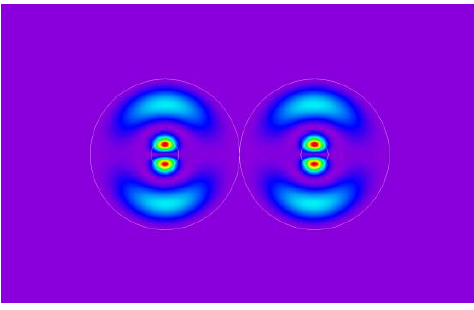
Figure 6. 2D power distribution plot for guided-mode ν = 22 ( 𝑛 𝑛𝑒𝑓𝑓 𝜈=22 = 1.427474).